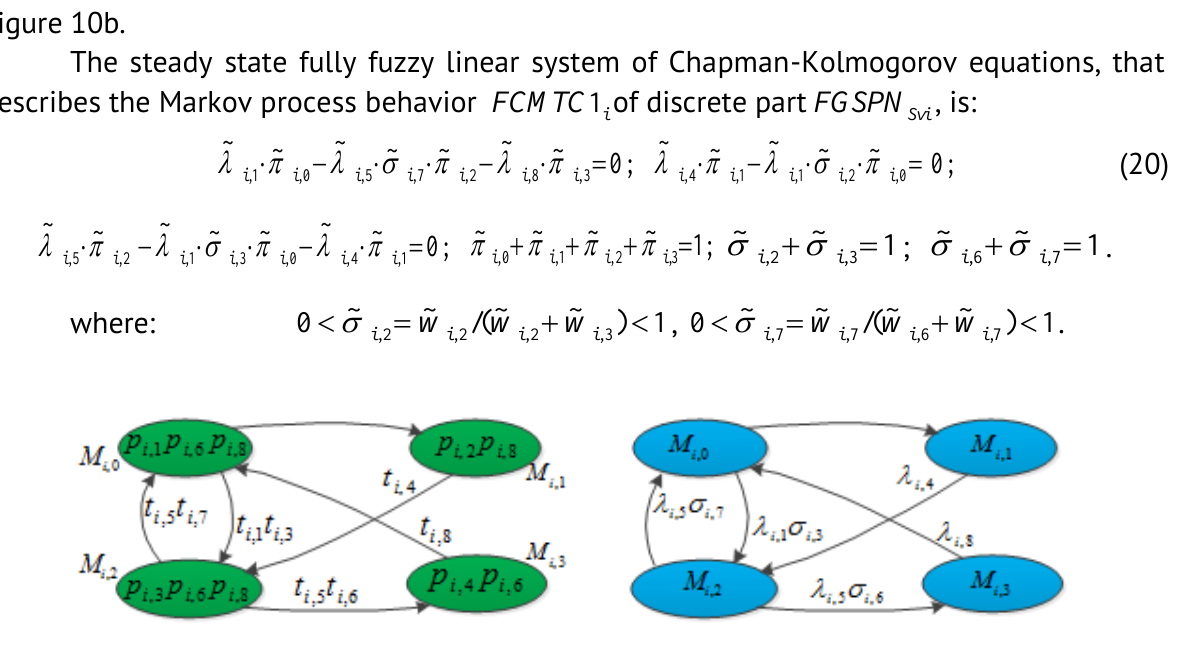
Figure 10 . The states transitiоn diagrams оf the discrete part